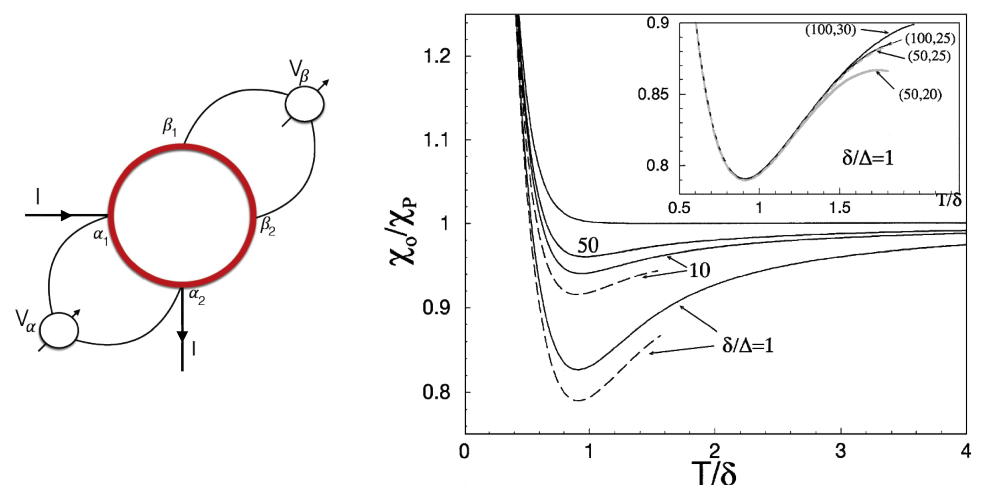
Figure 3: Left: In the four-terminal setup considered in Ref. [ 30 ] the two current probes are attached in α and α while the voltage probes are in β and β . The 1 2 1 2 dimensions of the ring (in red) should be of the order of the superconducting length ξ . Right [ 35 ] : The susceptibility of a small grain with a odd number of electrons is shown as a function of temperature, parametrised by different values of the ratio δ/ ∆ ( δ is the level spacing and ∆ is the BCS superconducting gap). This ratio quantifies the size of superconducting fluctuations. On increasing the pairing fluctuations, the non-monotonous behaviour becomes more pronounced. The inset shows details of the approximations used in the numerical evaluation of the pairing